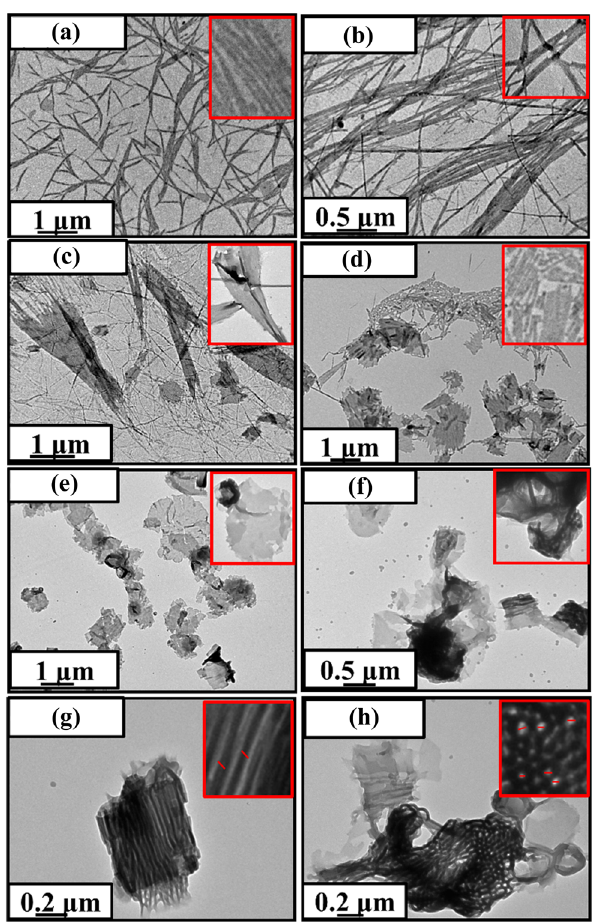
Figure 3: Representative TEM micrographs of BCP nanoparticles synthesized using PDMA 21 as a macro - CTA in 20% w/v EtOH solution at 60°: ( a ) fi brous morphology, ( b ) fused fi brous morphology, ( c ) fused lamellar morphology, ( d – f ) gradually fused layered structure, ( g ) multilayer fusion lamellar structure, and ( h ) porous fusion structure. ( a ) x = 10, ( b ) x = 15, ( c ) x = 20, ( d ) x = 25, ( e ) x = 30, ( f ) x = 35, ( g ) x = 40, and ( h ) x = 45.